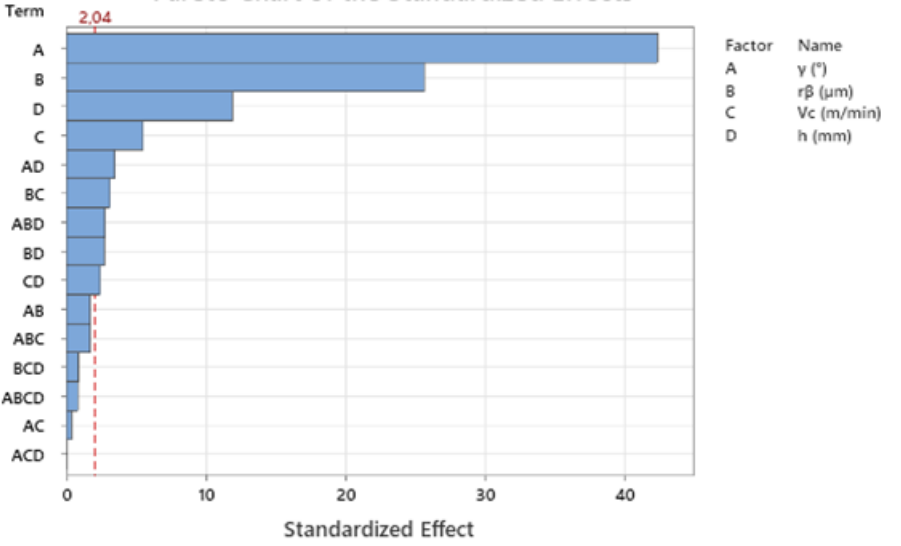
Figure 5. Pareto analysis of the factors affecting the thrust force ( F t ) based on all cutting conditions.